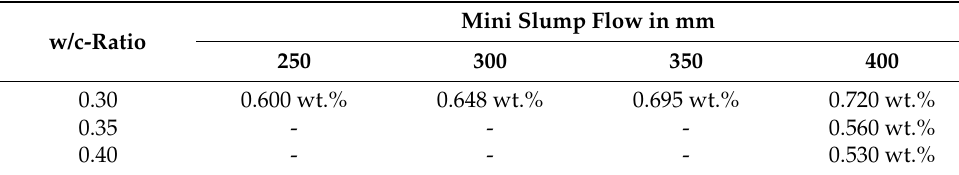
Table 1. Investigated cement pastes with superplasticizer contents in